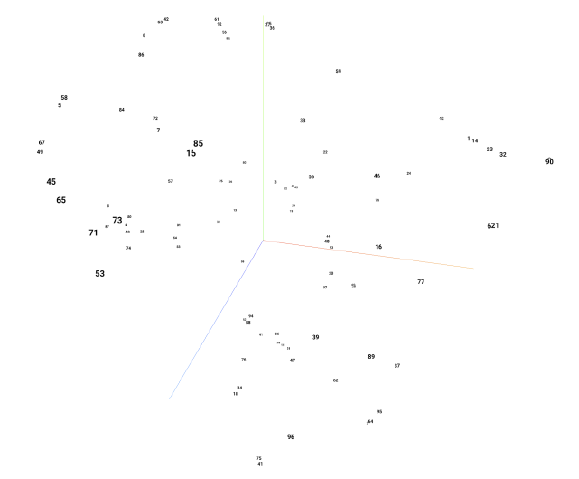
Figure 11. The demonstration of the t-SNE result with 1003 steps of